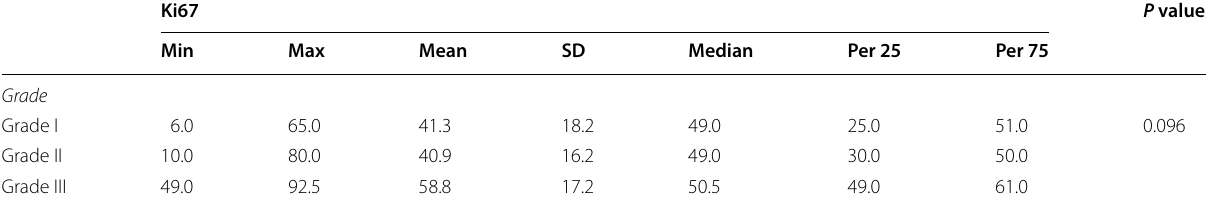
Table 7 Comparison of Ki67 regarding grade